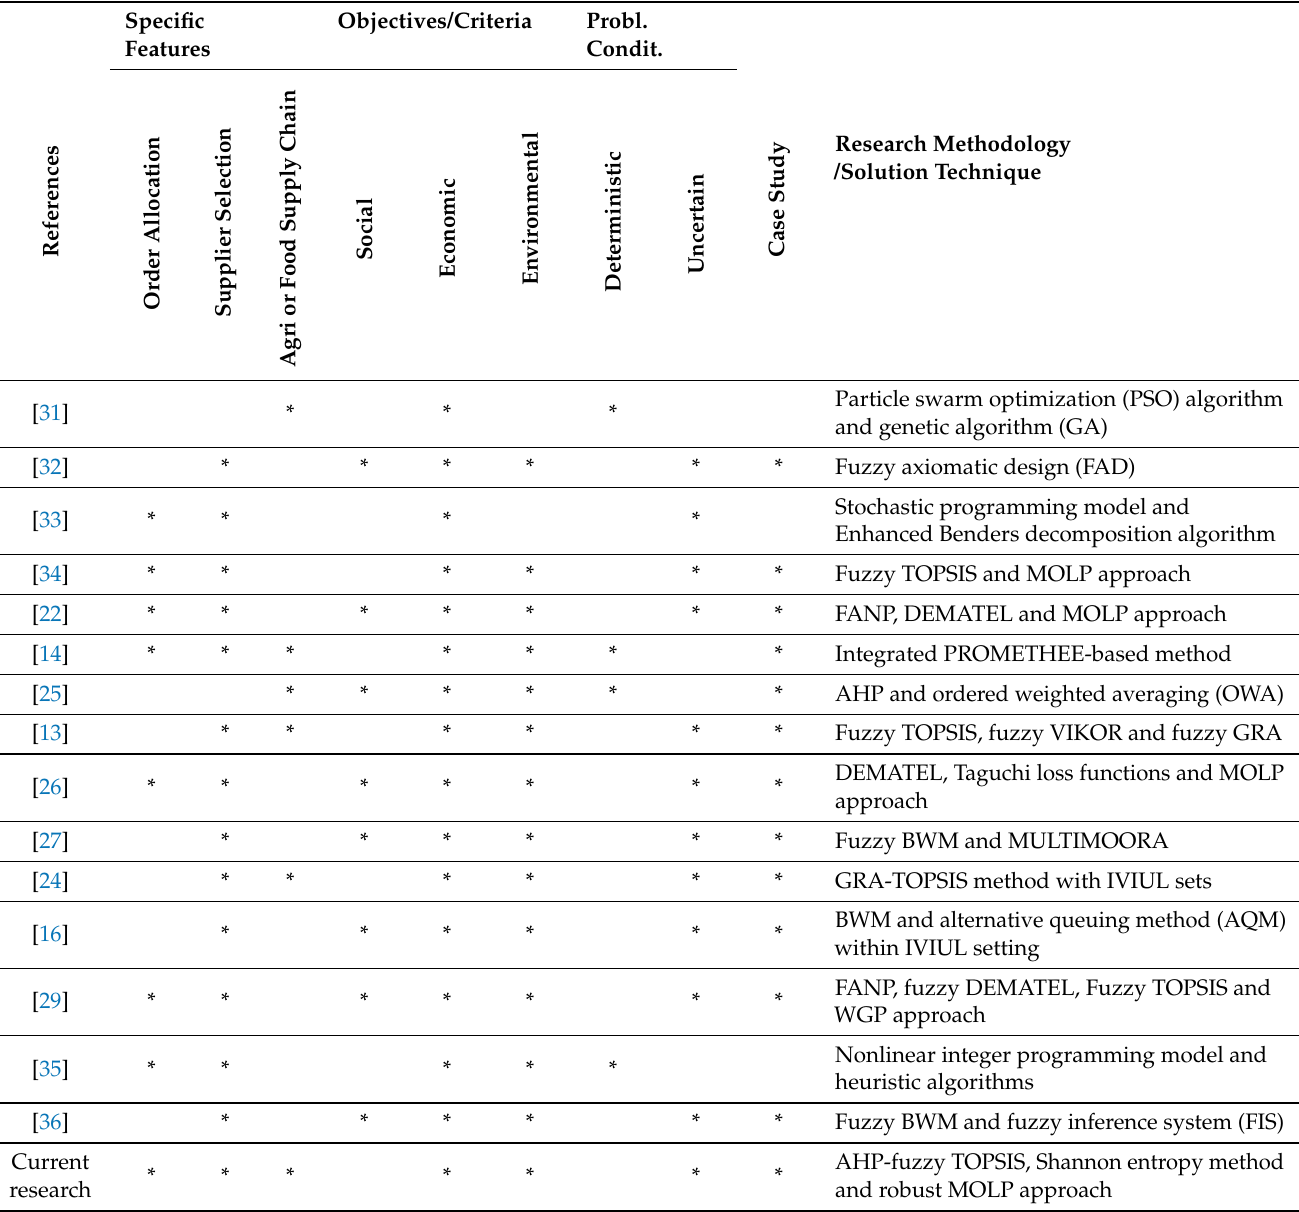
Table 1. Brief literature